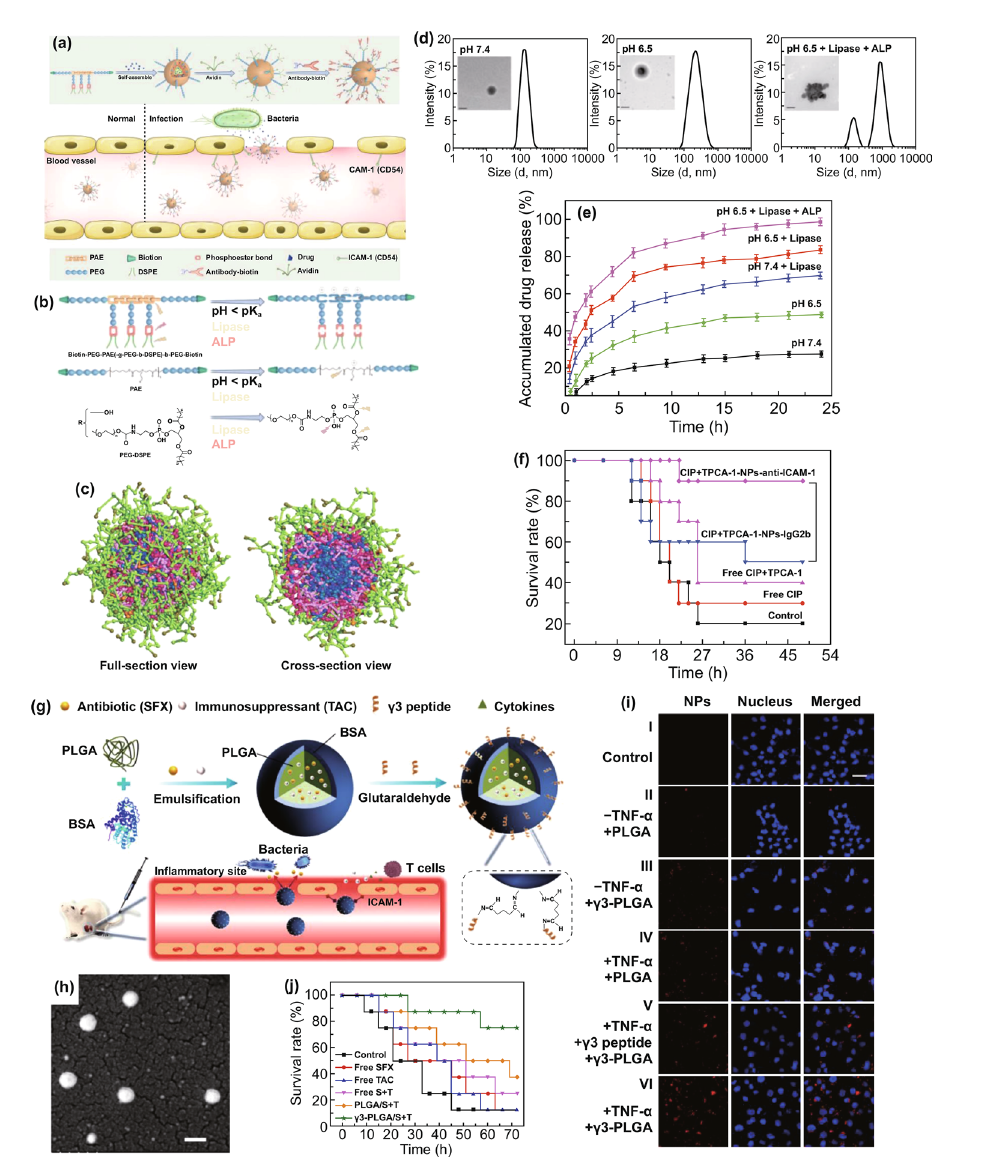
Fig. 20 Bioresponsive nanoparticles with dual therapeutic functions targeted to infectious microenvironments for sepsis management. a Rational design of IME-responsive nanoparticles with well-designed surface engineering for targeted delivery of therapeutic agent at the septic microenvironment. b Structure and pH/enzyme-responsive natures of amphiphilic block copolymer Biotin-PEG- b -PAE(- g -PEGb-DSPE)- b -PEG- biotin. c DPD simulation of the self-assembled behaviors of the bioresponsive amphiphilic block copolymer with the drug molecule CIP, HDD (1,6-hexanediol diacrylate) units in PAE and DSPE (peach), PEG moiety (light green), biotin group (dark green), AP (3-amino-1-propanol) units in PAE (pink), CIP molecule (blue). d Representative DLS size and TEM images of NPs-anti-ICAM-1 incubated in PBS at pH 7.4, pH 6.5 or pH 6.5 with lipase and ALP for 2 h, scale bars, 100 nm. e In vitro drug release of CIP-NPs-anti-ICAM-1 in different buffers. f Survival rates of peritonitis-induced septic mice obtained by i.p. injection of a lethal dose of P. aeruginosa . At 4 h after bacterial injection, mice were treated with different drug formulations. Reproduced with permission from Ref. [257]. Copyright 2018 John Wiley and Sons, Inc. Sparfloxacin and tacrolimus-loaded polymeric nanoparticles targeting inflammation for the treatment of acute lung sepsis. g Schematic illustration of γ3 peptide- functionalized PLGA nanoparticles loaded with both SFX and TAC for improved treatment of lung-infected mice by targeting the inflammatory site. h SEM images of γ3-PLGA NPs. i CLSM images of interaction of PLGA NPs with HUVECs; cell nuclei (blue), PLGA NPs (red). j Sur- vival rates of P. aeruginosa -induced septic mice after various treatments. Reproduced with permission from Ref. [258]. Copyright 2020